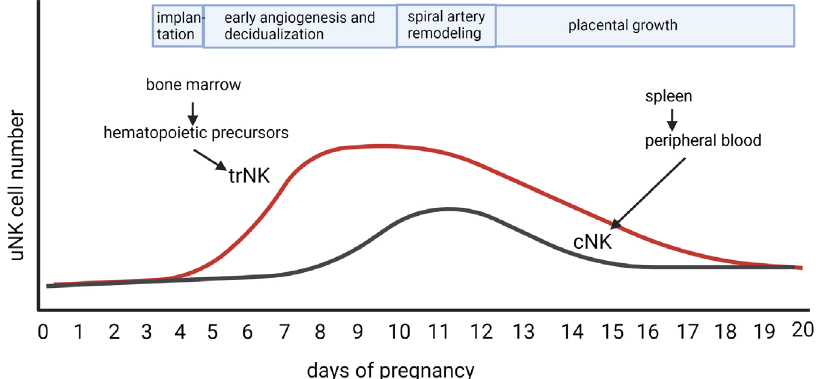
Figure 2. Number of uNK cells at different time points of pregnancy in the mouse. The mouse placenta has two uNK cells subsets, trNK and cNK cells. trNK cells are derived from hematopoietic precursors from the bone marrow and proliferate in early pregnancy and peak in the placenta from day 8–12 and thereafter decrease towards the end of pregnancy. These cells are important for decidual angiogenesis and spiral artery remodelling. cNK cells are recruited from the peripheral blood to the placenta around day 9 and peak on days 11–12. They produce IFNγ, which is important for spiral artery remodelling (Created with BioRender.com)